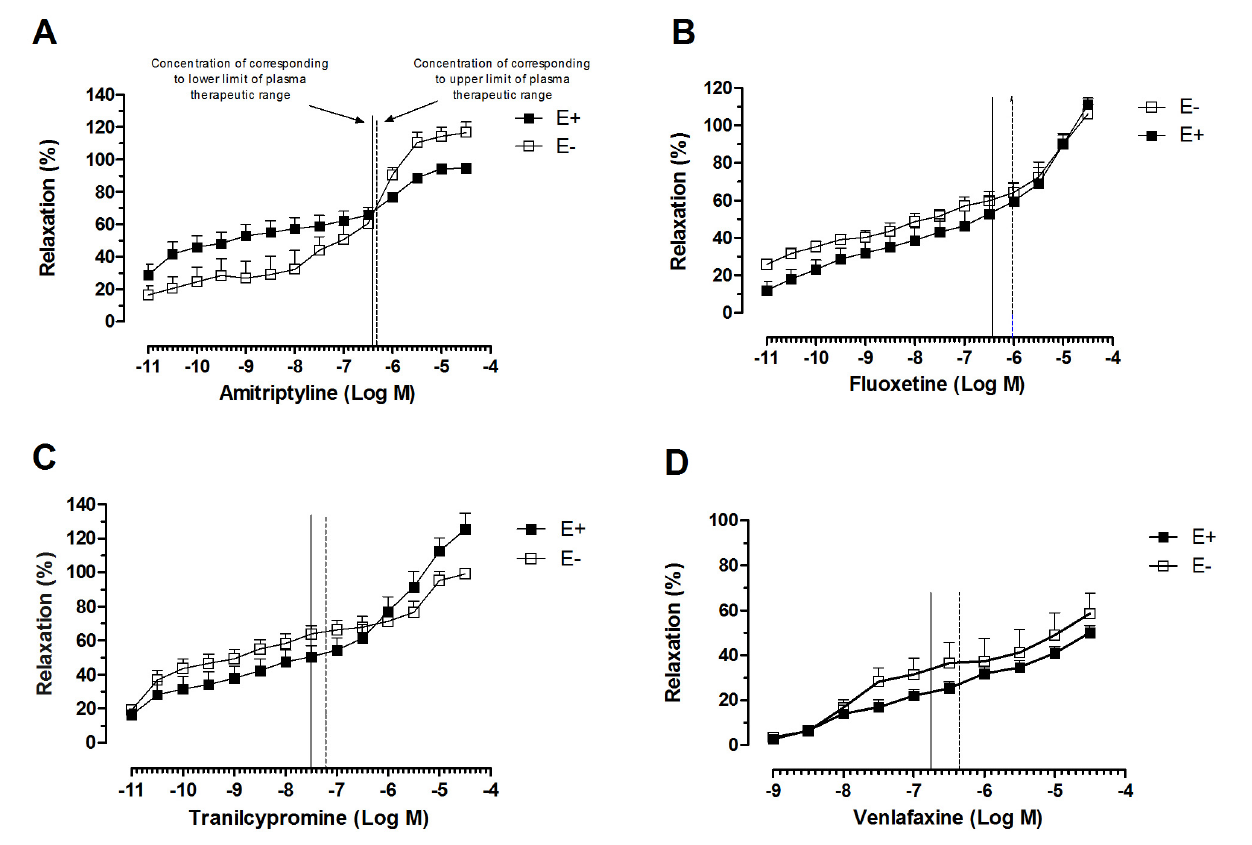
Fig. 1 – Graph of concentration-relaxation (%) induced by amitriptyline (A), fluoxetine (B), tranylcypromine (C) and venlafaxine (D) added cumulatively to isolated human saphenous vein grafts with endothelium precontracted with submaximal phenylephrine (3×10 -6 M) (E+) and mechanically damaged endothelium (E-) (n=8 for each drug). The vertical line in the graph represents the lower limit of therapeutic plasma concentrations of these drugs in humans. The dotted vertical line in the graph represents the upper limit of the therapeutic plasma concentrations of these